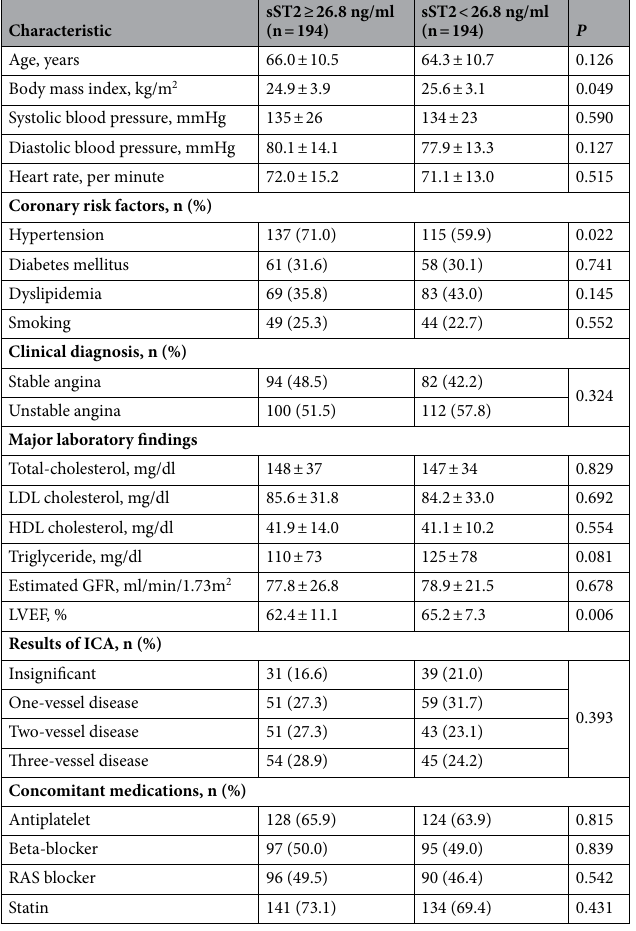
Table 3. Clinical characteristics of study patients according to soluble ST2 level. LDL low-density lipoprotein, HDL high-density lipoprotein, GFR glomerular filtration rate, LVEF left ventricular ejection fraction, ICA invasive coronary angiography, RAS renin-angiotensin